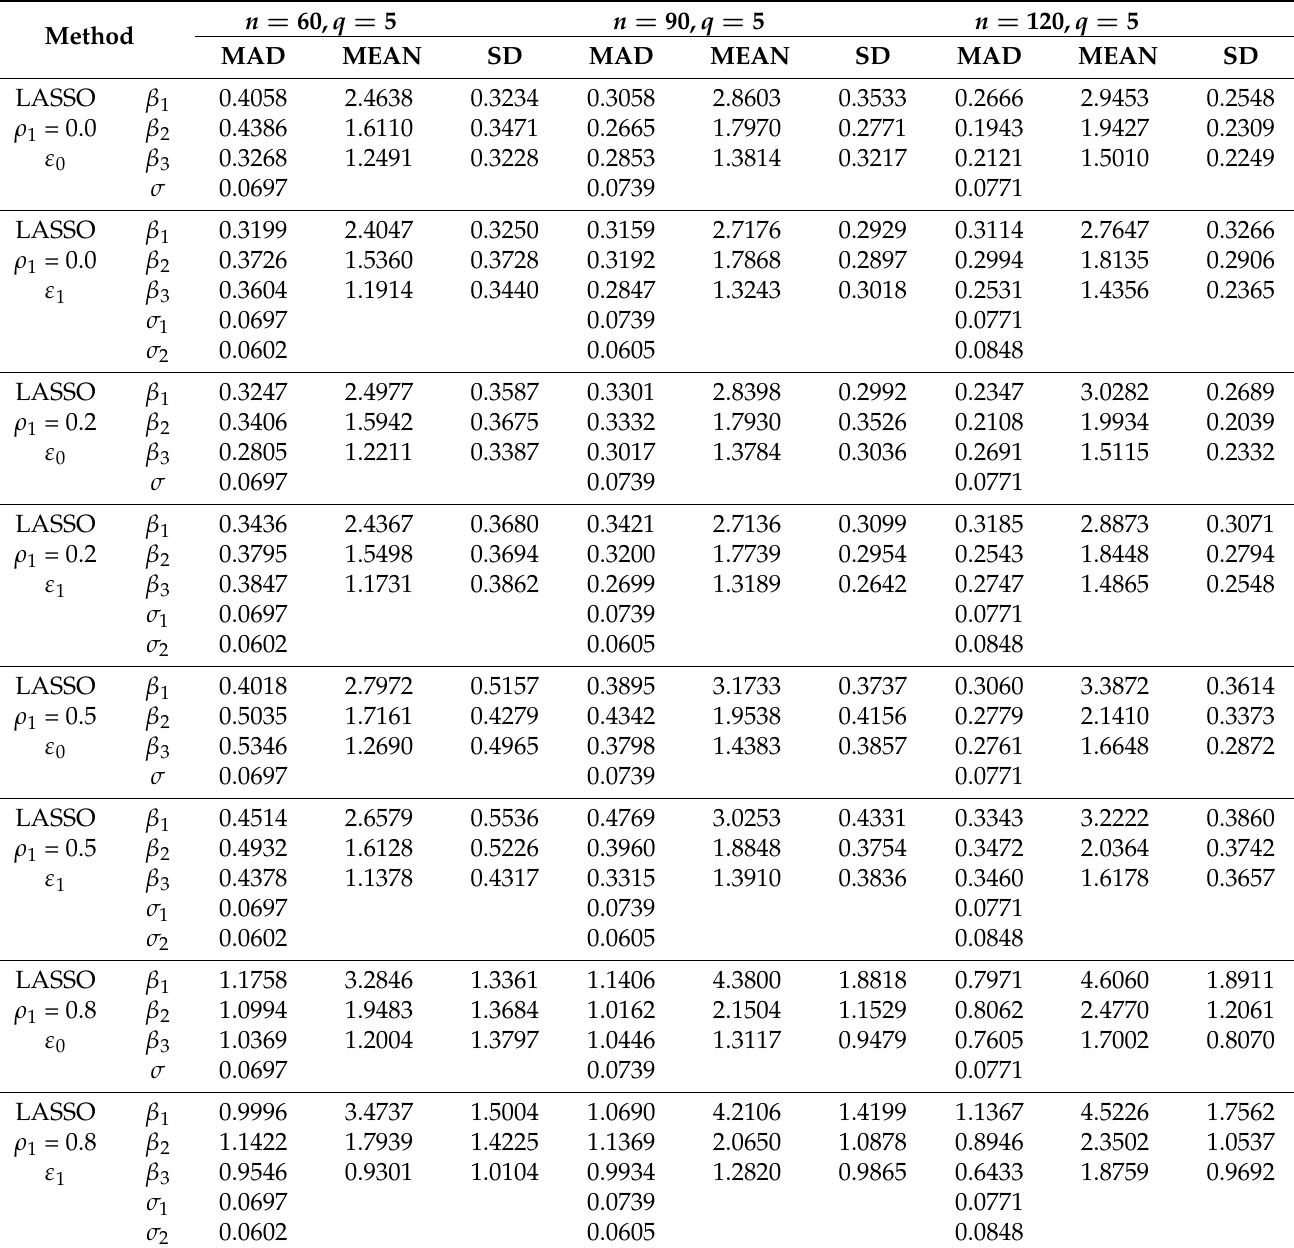
Table 7. Standard deviations and means of estimators of the nonzero regression